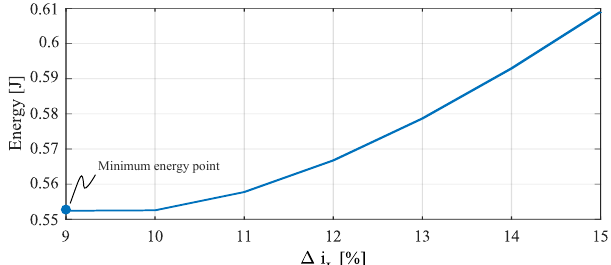
Figure 9. Ripple sweep analysis for calculating the stored energy in the input filter passive elements.